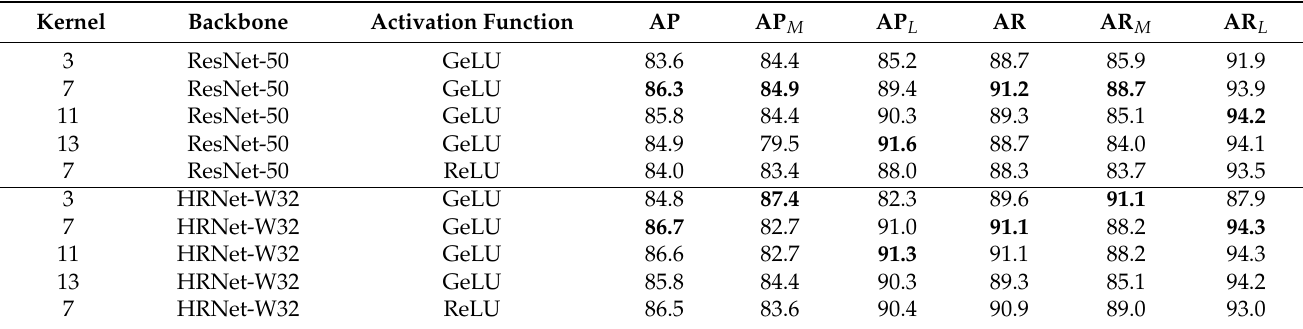
Table 4. Effect of different sizes of reception field on aircraft pose